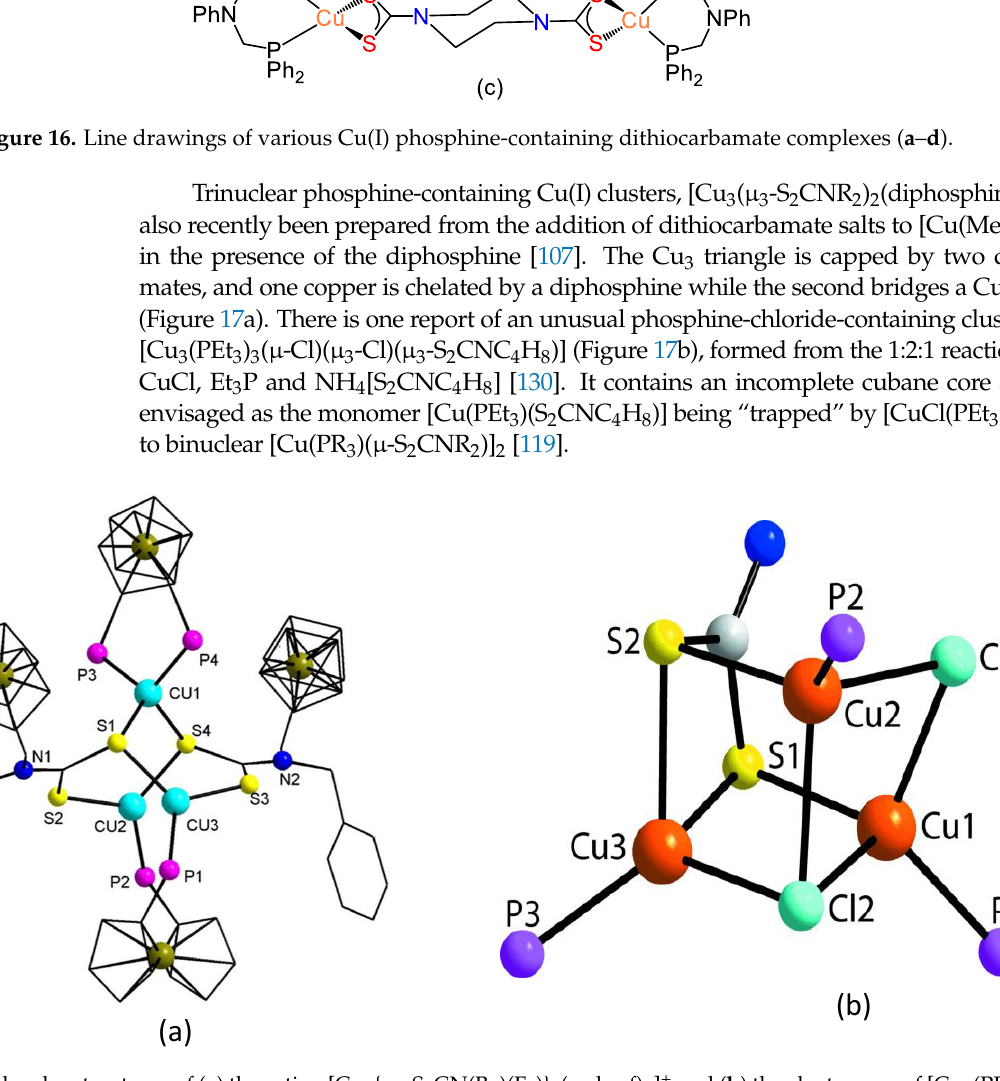
Figure 17. Molecular structures of ( a ) the cation [Cu 3 { μ 3 -S 2 CN(Bz)(Fc)} 2 ( μ -dppf) 2 ] + and ( b ) the cluster core of [Cu 3 (PEt 3 ) 3 ( μ - Cl)( μ 3 -Cl)( μ 3 -S 2 CNC 4 H 8 )]. Reproduced with permission from [107]. Copyright 2016 American Chemical Society, and IUCr [130].